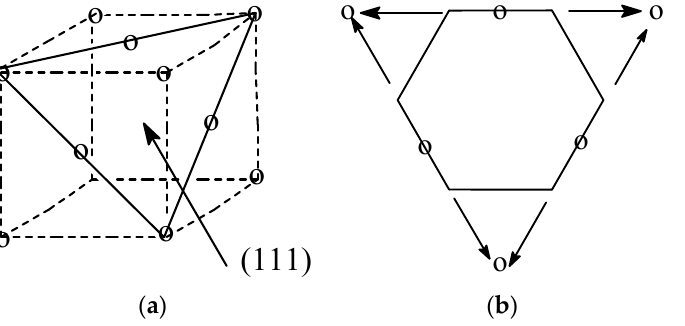
Figure 3. The scheme of correspondence of the parameters of the FCC lattice of the metal (plane 111) ( a ) and the cyclohexane molecule (( b )—projection from above) (o—means the location of the metal atoms of the catalyst) (arrows indicate the direction of interaction of hydrogen atoms of cyclohexane with the catalyst atoms) (Figure modified from [25]). Table 1. Lattice parameters of metals most active in the hydrogenation of benzene and dehydrogena- tion of cyclohexane (Data from [13]).